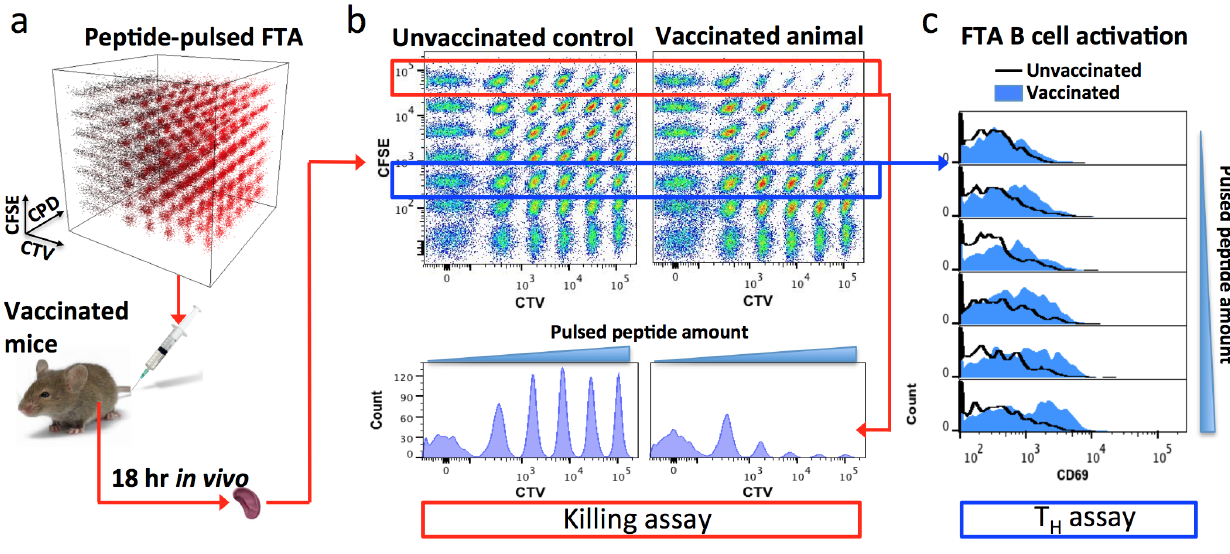
Figure 1. Schematic representation of a 252-parameter FTA assay. Splenocytes from mice were labeled with combinations of CTV (0 nM, 350 nM, 1295 nM, 4792 nM, 17729 nM and 65595 nM), CFSE (0 nM, 79 nM, 315 nM, 1106 nM 3859nm, 13505nm and 47269 nM) and CPD (0 nM, 106 nM, 690 nM, 2738 nM, 10262 nM and 38506 nM) to generate 252 discernable cell clusters. Cell clusters were pulsed with MHC-binding peptides (as outlined in Figure 3) to generate a panel of 42 peptide pulsed clusters and this repeated 6 times to generate 6 intra-animal repeats (i.e., 252 target cell clusters in total). Target cells were also labeled with DiI for discrimination from host splenocytes (not shown). (a) FTA cells were injected i.v. into host mice that had 6 days earlier been vaccinated with VV-HIV or left unvaccinated as a control. 18 hr after FTA injection, splenocytes were collected and target cells delineated from host splenocytes by DiI label using flow cytometry (not shown). (b) 2D plots of the fluorescence intensities of a panel of one replicate of the 42 peptide-pulsed clusters from the unvaccinated and vaccinated animals and an associated histogram analysis of clusters pulsed with titrations of the F2L CTL epitope, revealing killing in vaccinated animals. (c) An example of histogram analysis of the FTA T helper assay, with B220 + FTA cells pulsed with the Gag Th T H cell epitope being assessed for CD69 up-regulation from the vaccinated animal compared to those from the unvaccinated animal.